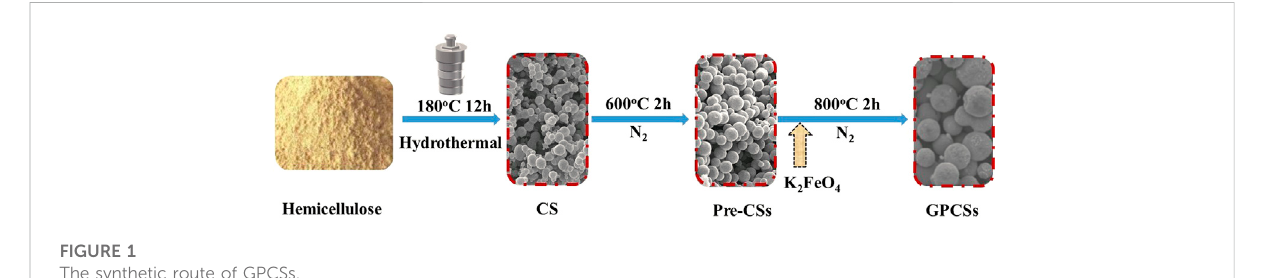
FIGURE 1 The synthetic route of